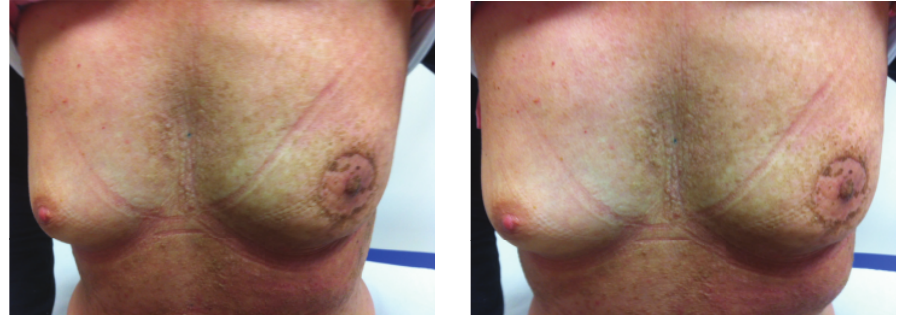
Figure 3: Skin features after 1 month.